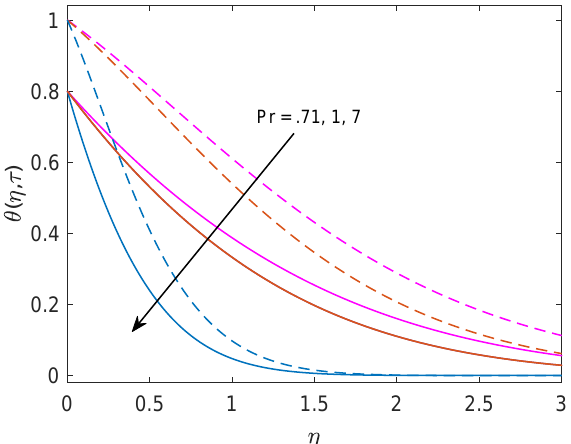
Figure 12. Effect of different values of Pr.